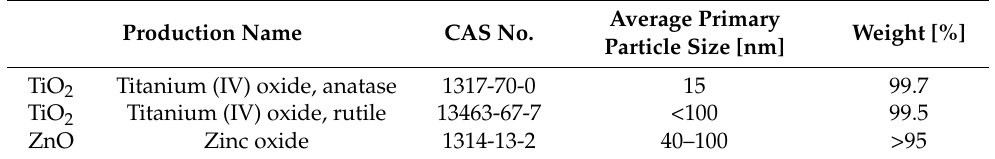
Table 1. Basic properties of TiO 2 and ZnO nanoparticles.